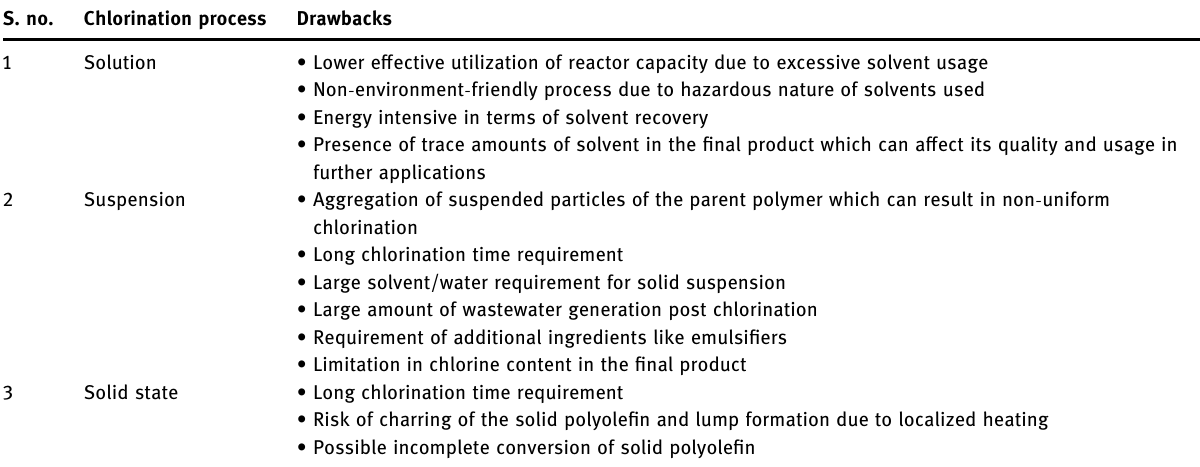
Table 1: Drawbacks of solution, suspension, and solid - state chlorination processes S.